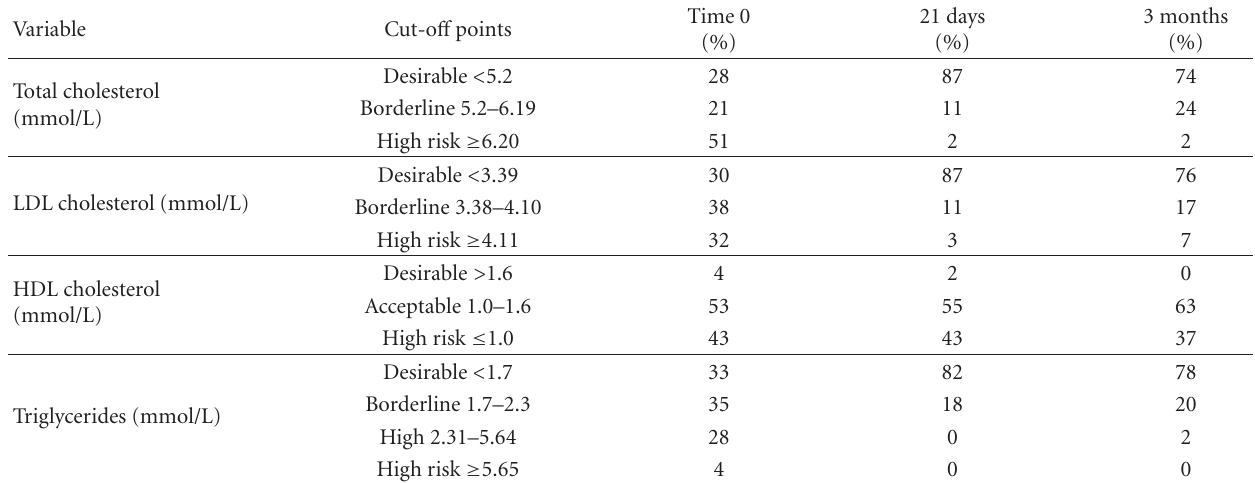
Table 5: Lipids and cardiovascular risk in adult type 2 diabetic adults with Ma-Pi 2 diet.